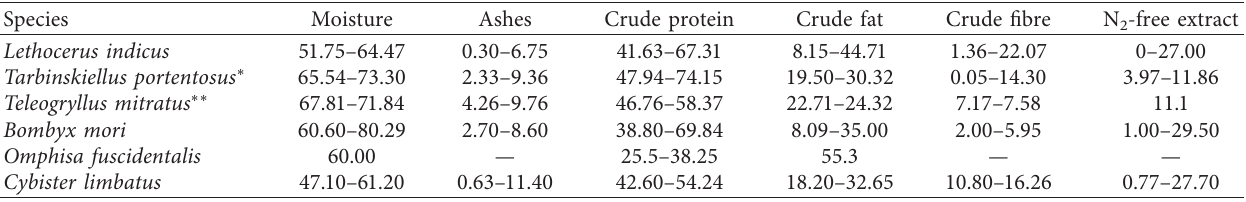
Table 4: Proximate chemical composition (%, dry matter base; nonprocessed) of sampled species (or similar) according to [1, 5, 7, 8, 10–20]. Species Moisture Ashes Crude protein Crude fat Crude